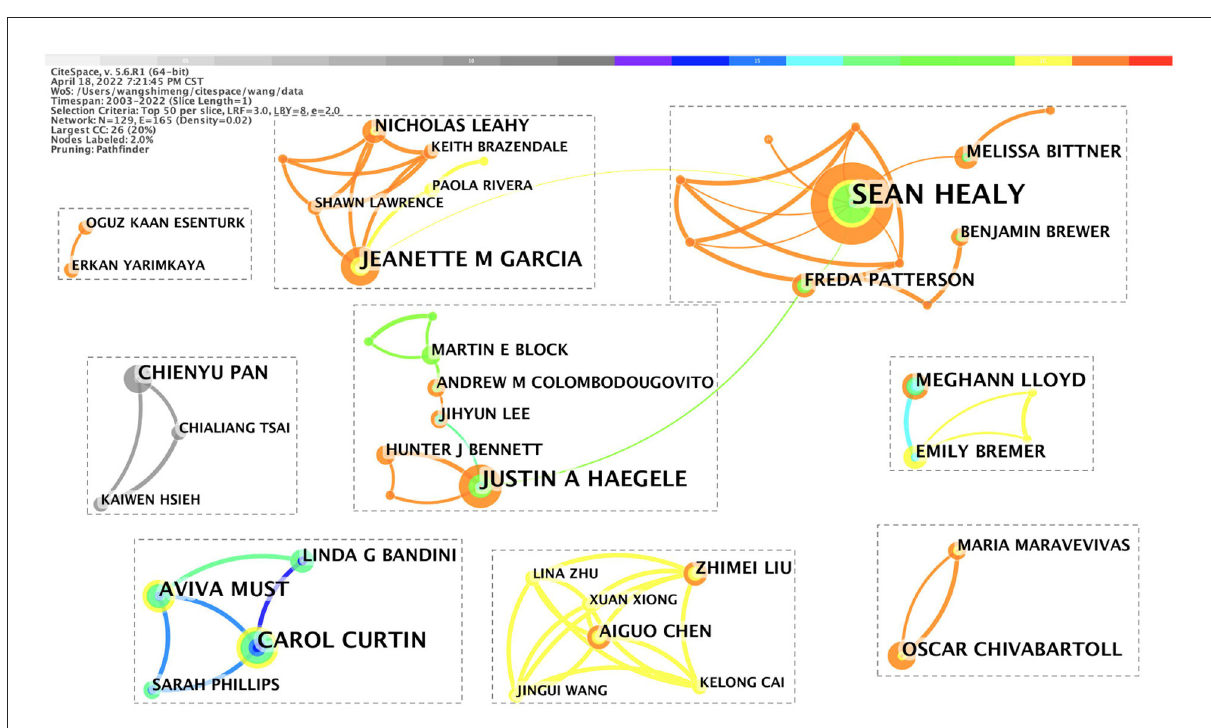
FIGURE4 Co-authorship network (1 January 2003 to 1 March 2022). The color of the line represents the time the co-authors worked together. The larger the node diameter, the more studies the author has collaborated to publish. The thicker the line between the two